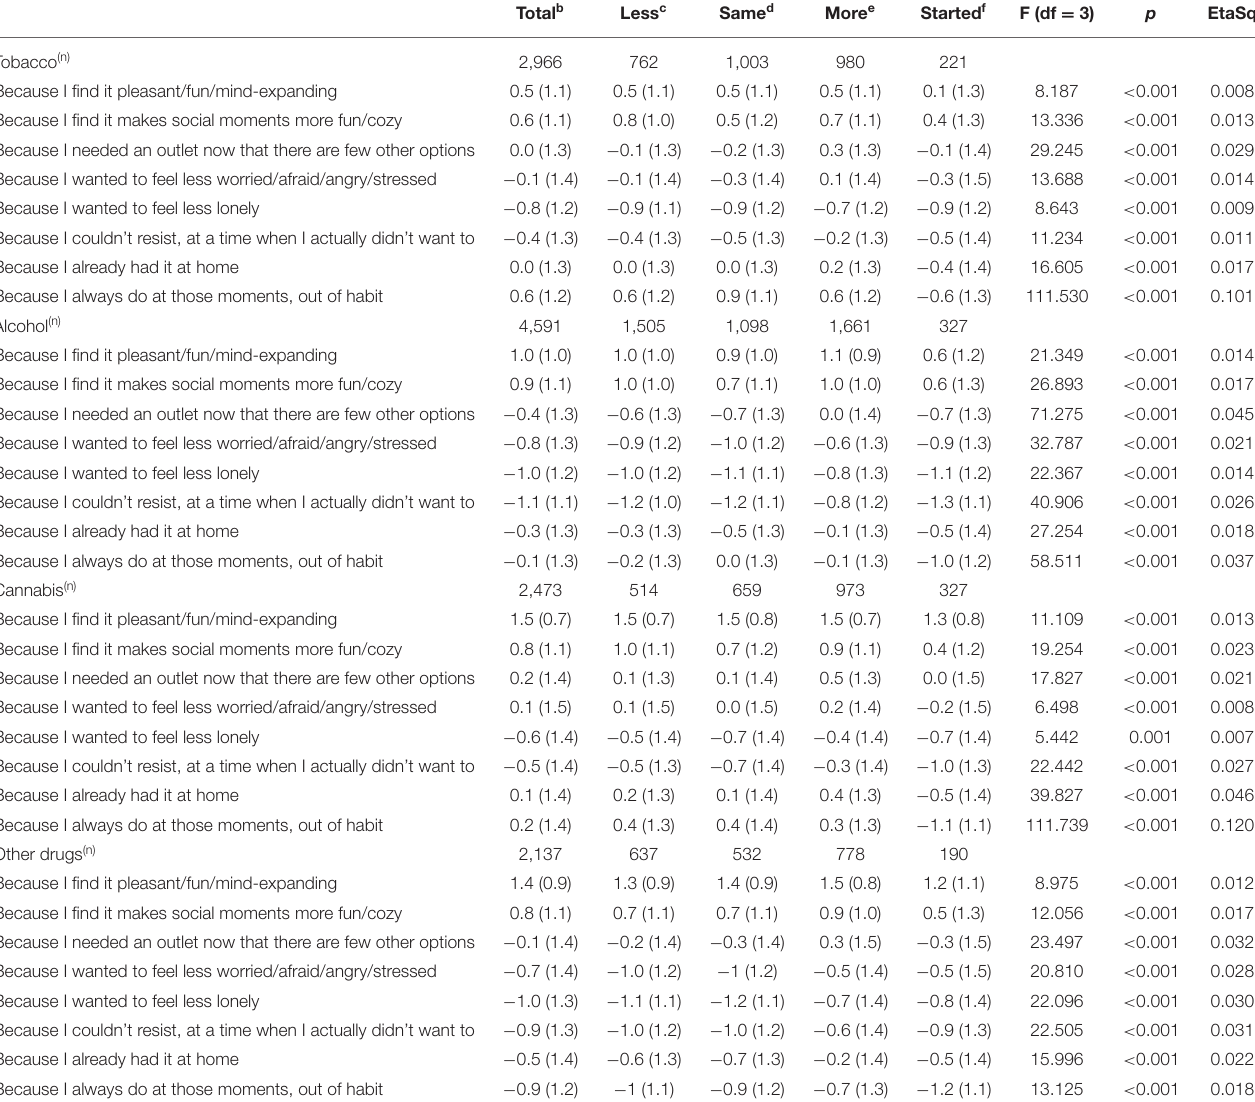
TABLE 4 | Reasons for current use a